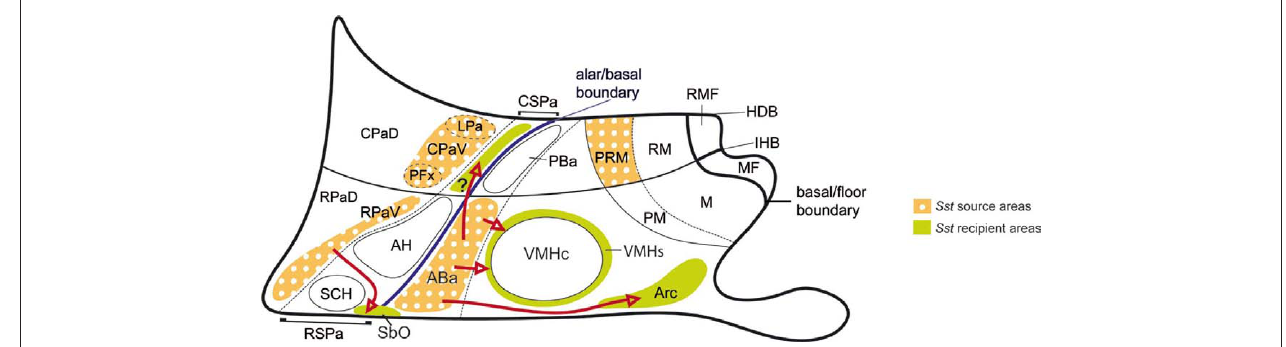
not clearly distinguishable in our material. Note that we described radial migrations toward intermediate or subpial loci at the ventral subdomains of CPa and RPa (CPaV, RPaV) and PRM areas. Only the radial migration finishing at the suboptic nucleus (SbO; or retrochiasmatic supraoptic nucleus) is